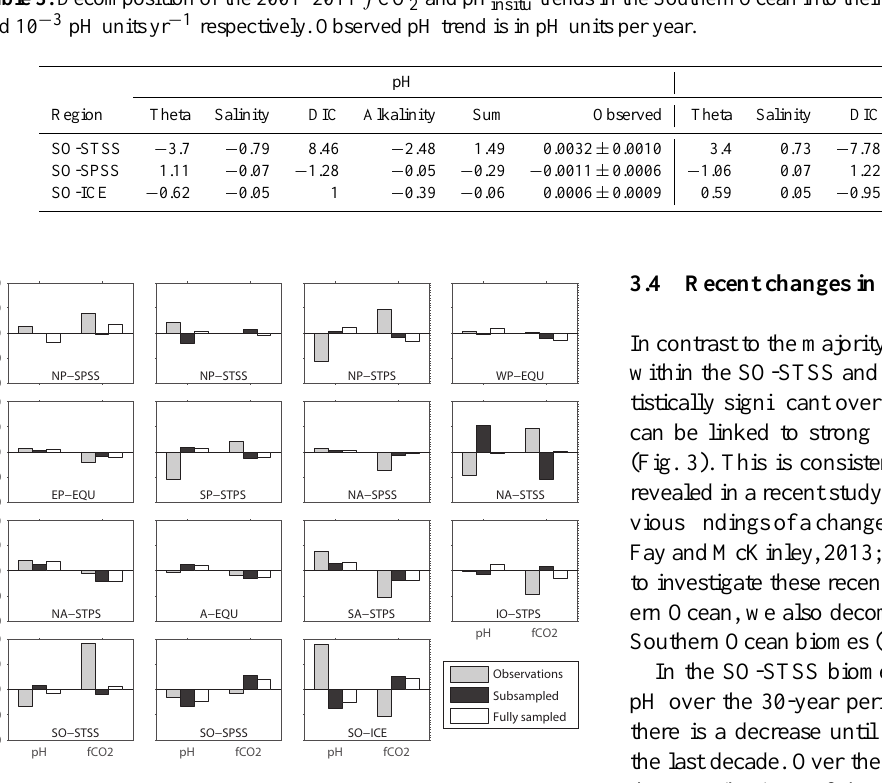
Figure 10. The residual between the actual pH trends and the sum of the four decomposition parts (SSS, SST, DIC, ALK). In gray is the residual for the observations, in black the residual for the sub- sampled model output, and in white the residual for the fully sam- pled model